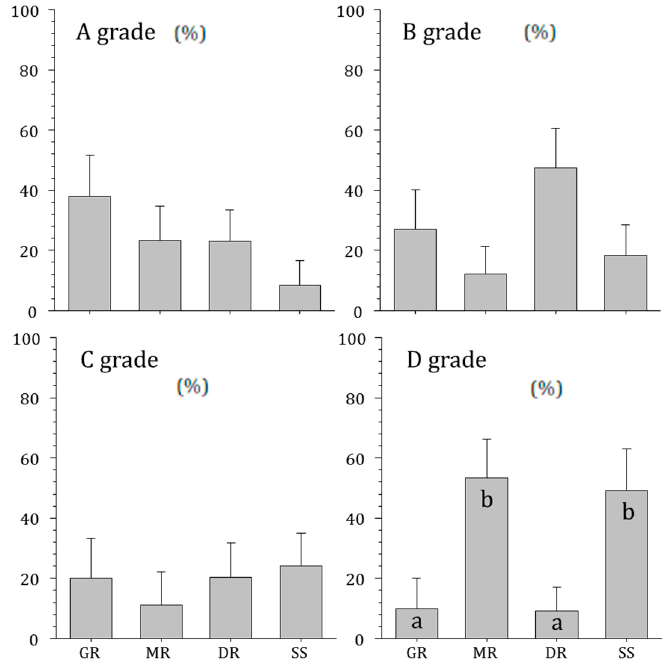
Figure 4. Land use of four central western major streams of the Korean Peninsula (GR: Geumgang River, MR: Mangyeonggang River, DR: Dongjingang River, SS: Sapgyocheon stream). Soil characteristics by the rivers were also surveyed (Figure 5). There was no significant difference in the proportion of class A, B, and C soils in the rivers, but the proportions of class D soil were lower in the Geumgang River (10.0%) and the Dongjingang River (9.1%) and higher in the Mangyeonggang River (53.3%) and Sapgyocheon stream (49.1%) (ANOVA, p < 0.01). Soil characteristic is an important factor in analyzing runoff due to rainfall. For example, Class D soil causes relatively higher runoff [13].